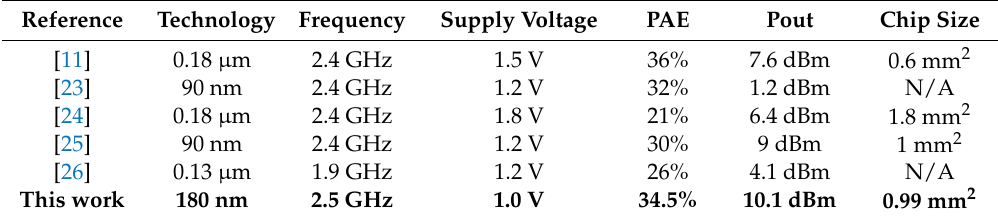
Table 1. Summary of the proposed PA IC with several published works.